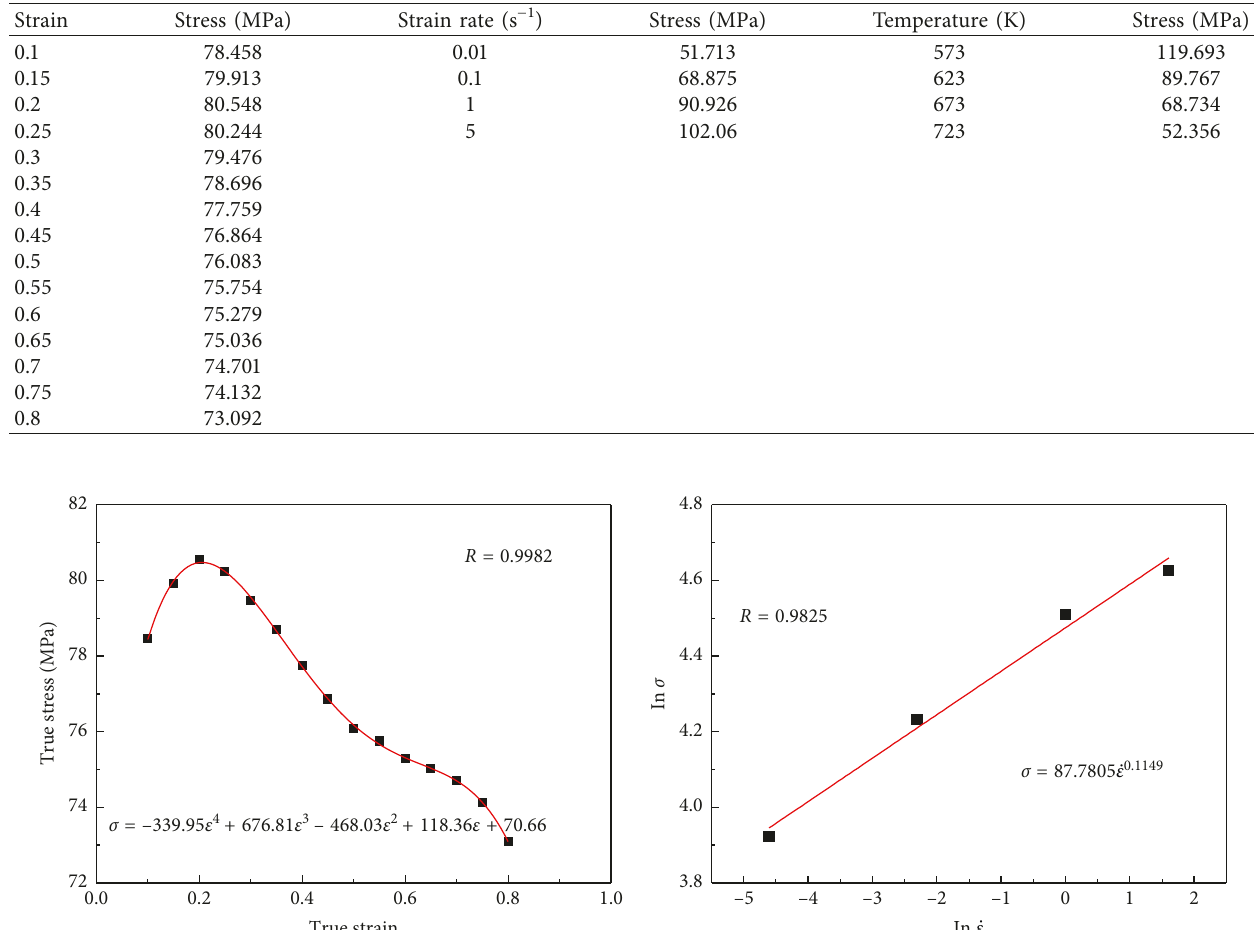
Table 5: Average values of the flow stress of the AA6061 alloy.